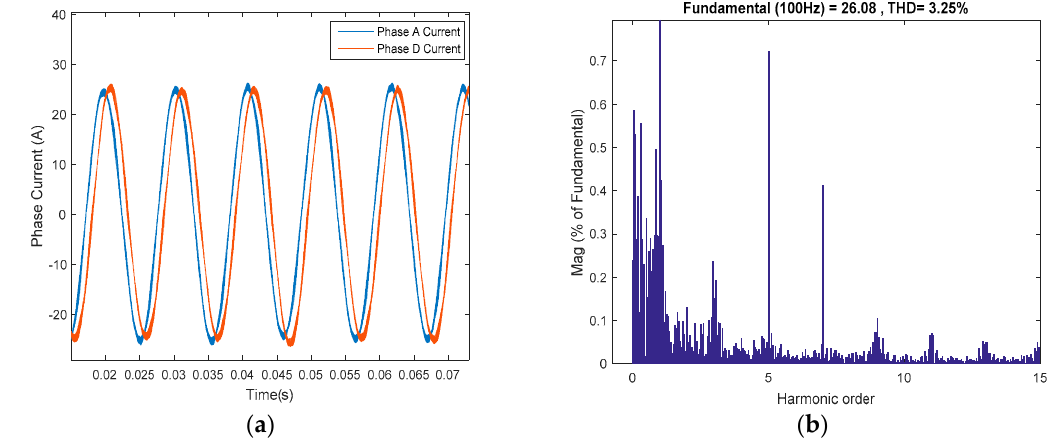
Figure 16. Experimental results after adopting the ADALINE-based voltage compensator when the motor speed is 1500 rpm, ( a ) Phase A and D currents and ( b ) THD for phase A current.